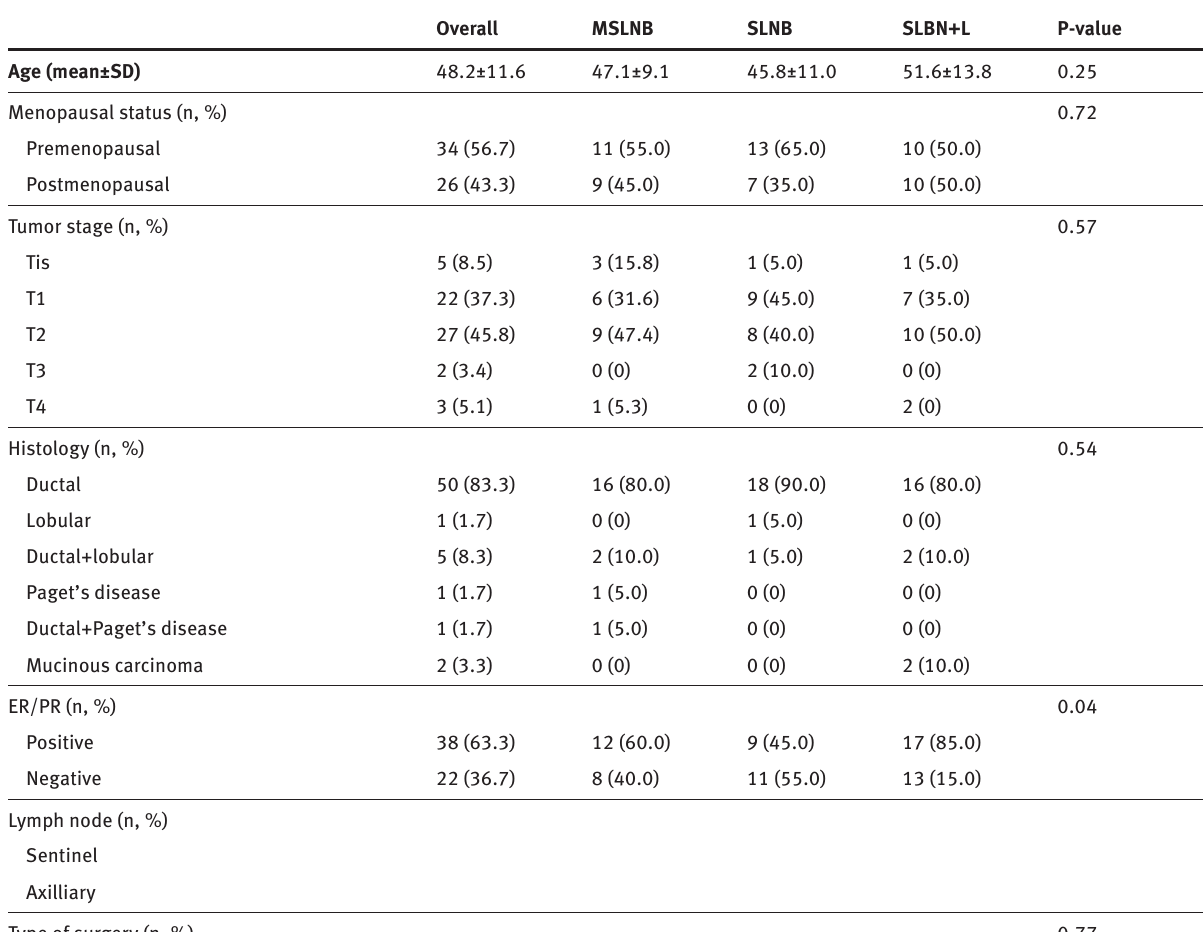
Table 1: Clinical and pathologic characteristics of the 60 patients undergoing sentinel node